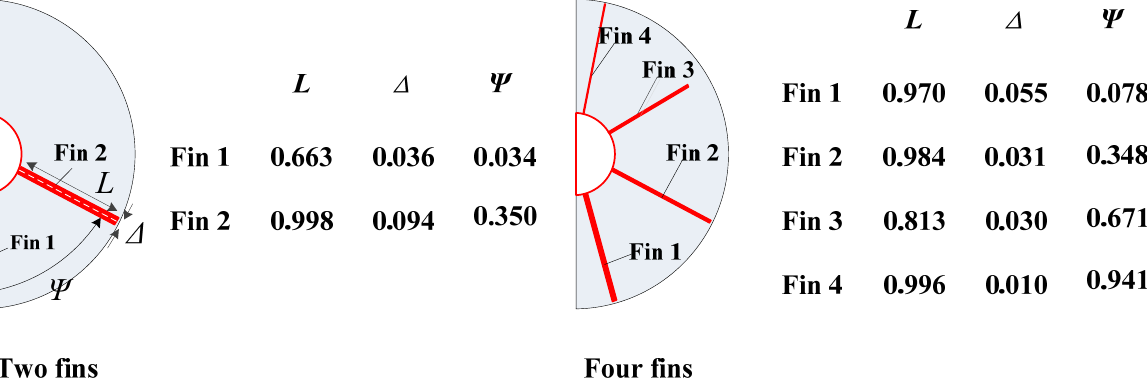
Figure 15. Optimal structure and position of the double fins and four fins.